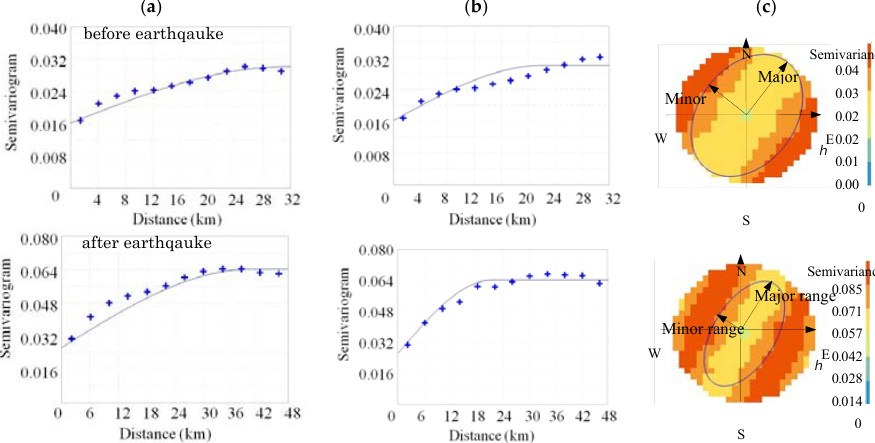
Figure 4. Experimental variograms of NDVI data calculated from two images of Landsat ETM+ data before (5 April 2008) and after (23 May 2008) the Wenchuan earthquake at the study area. Variograms ( a ) along the major range and ( b ) along the minor range; and ( c ) variogram surfaces when plotting the average values of data pairs separated by similar distances (shown by the distance from the center) and angle at each azimuth (0–360°). Curves on the variograms express spherical models that approximate the trends. Ellipses on the variogram surfaces indicate the range for each direction.